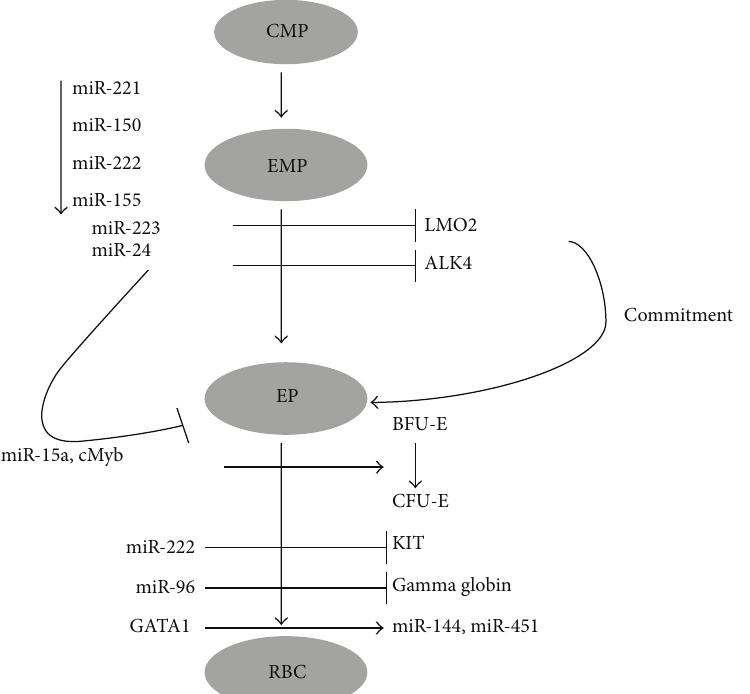
Figure 7: miRNA in erythropoiesis. miRNA in the erythrocyte development. (EP-erythroid progenitor, BFU-E-burst forming unit erythroid, CFU-E-colony forming unit